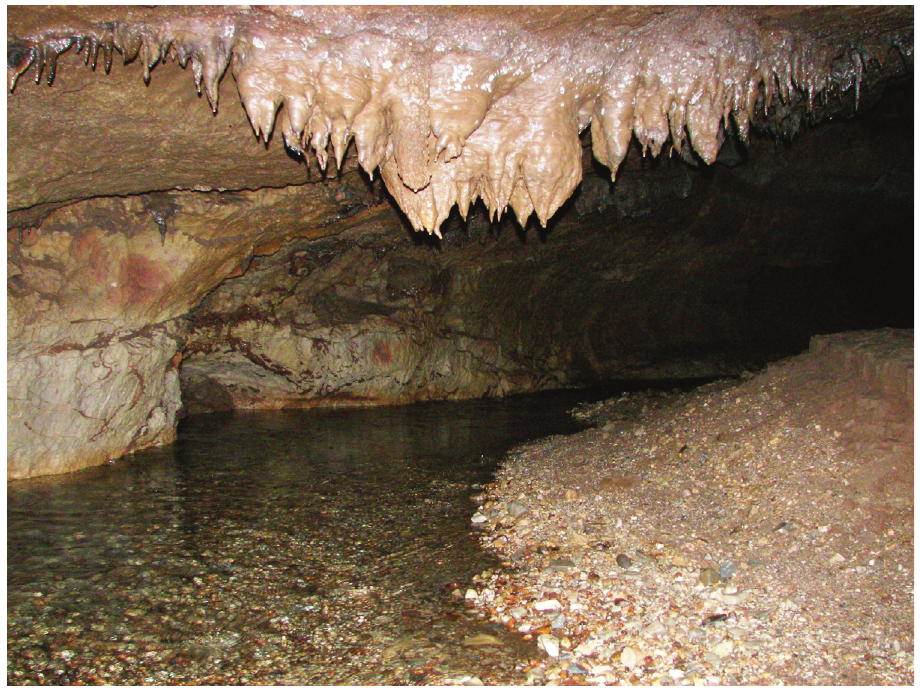
Figure 7. Soprador do Carvalho Cave, type locality of Iberoporus pluto sp.